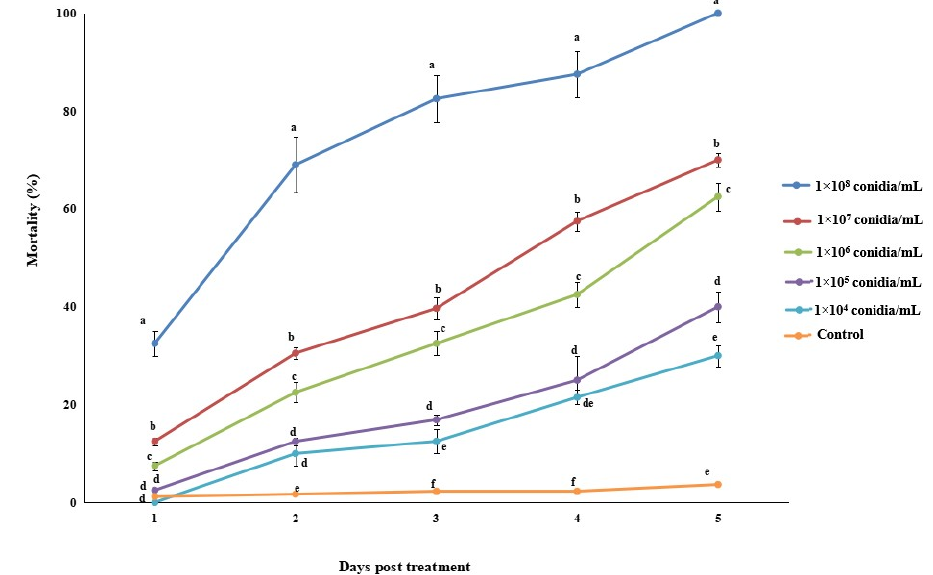
Figure 2. Percentage mortality of M. usitatus in response to A. attenuatus applications at different time intervals. Error bars indicate standard error of means based on three replicates. Bars having different letters at different days post treatment were significantly different from each other.